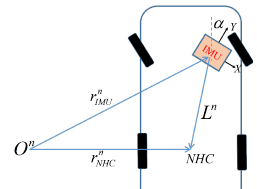
Figure 2. NHC level arm and boresight misalignment of smartphone